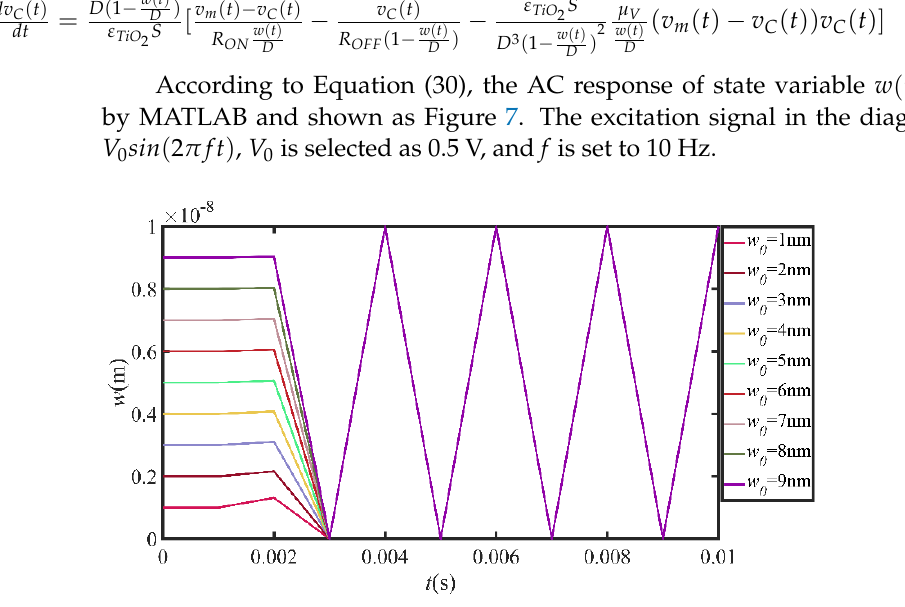
Figure 7. AC response of state variable w ( t ) to t considering parasitic memcapacitance, in which the excitation signal is v m ( t ) = V 0 sin ( 2 π ft ), V 0 is selected as 0.5 V, and f is set to 10 Hz.